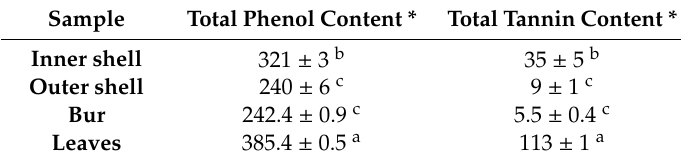
Table 1. Total phenol and tannin contents of chestnut by-products (mean value ± SD, n =